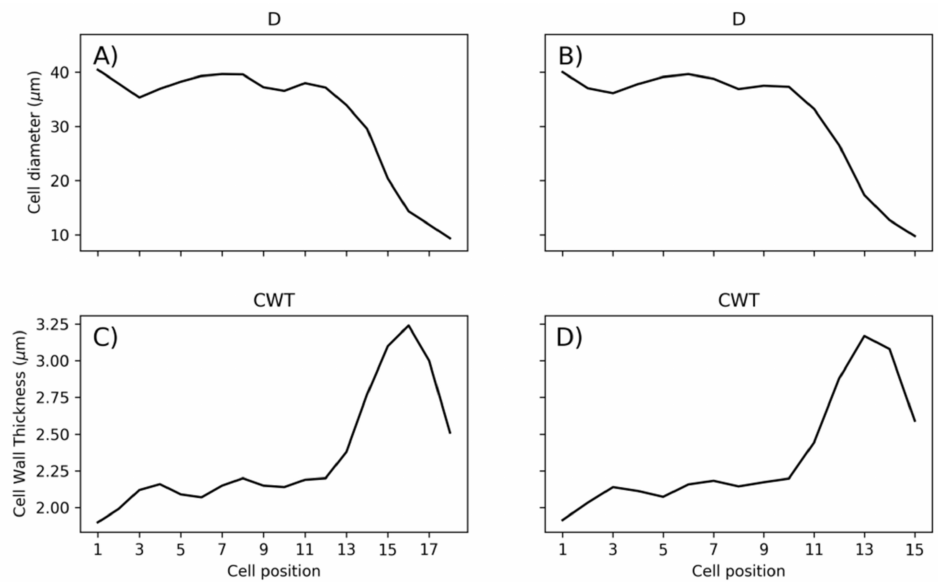
Figure 2. Raw ( A ) and standardized to 15 cells ( B ) tracheidogram for the radial cell size D; raw ( C ) and standardized to 15 cells ( D ) tracheidogram for the cell wall thickness CWT for tree 1 in 2000. To increase the value of intra-seasonal structure features in further statistical assess- ments of the tracheidograms, we used the “deviation tracheidogram” approach [14,35] (Figure